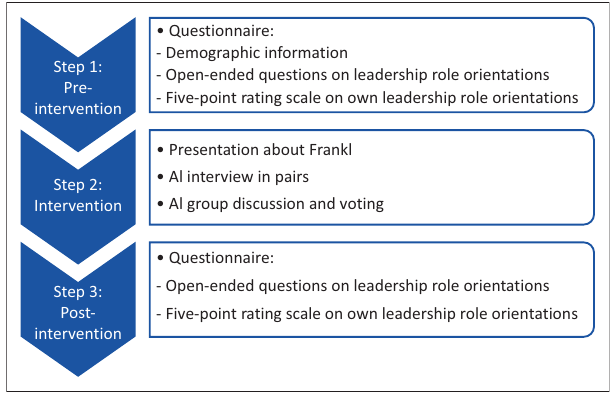
FIGURE 1: Summary of data collection